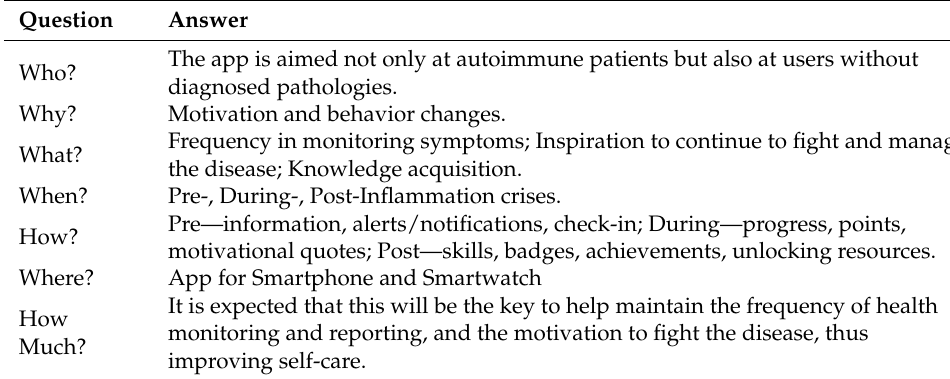
Table 3. Concept answers based on the 5W2H